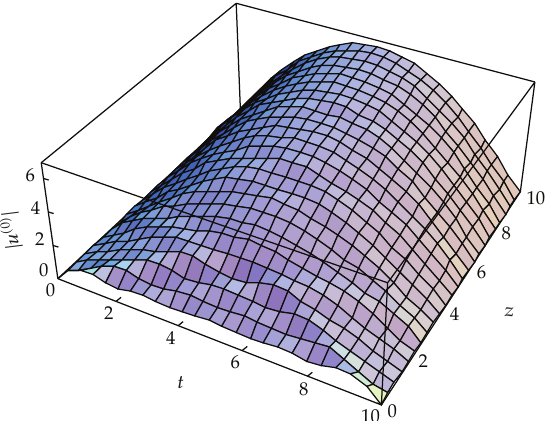
Figure 19: The zero-order approximation of | u (cid:3) 0 (cid:4) | at α (cid:8) 1, T (cid:8) 10, γ (cid:8) 02 with considering only one term in the series (cid:3) M (cid:8) 1 (cid:4)